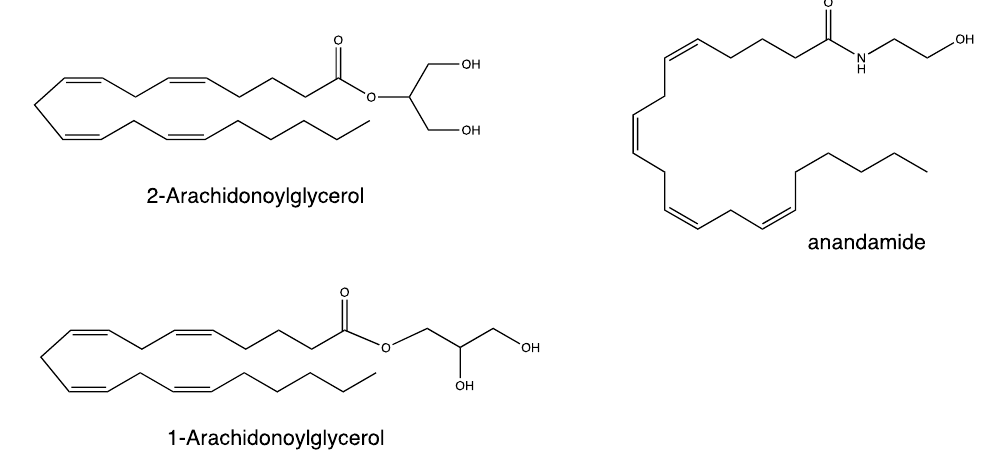
Figure 1. Structure of 2-Arachidonoylglycerol (2-AG), 1-Arachidonoylglycerol (1-AG), N -arachi- donoylethanolamine